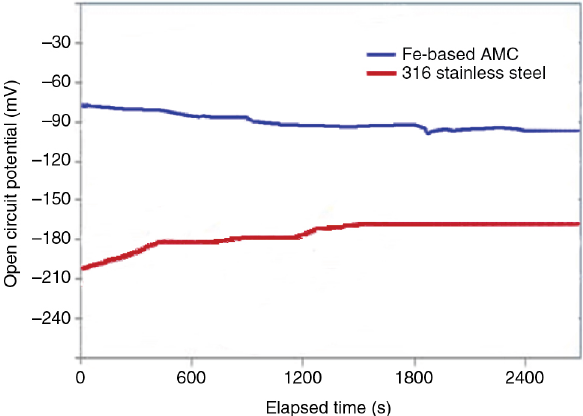
Figure 7: OCP curves for an Fe-based amorphous